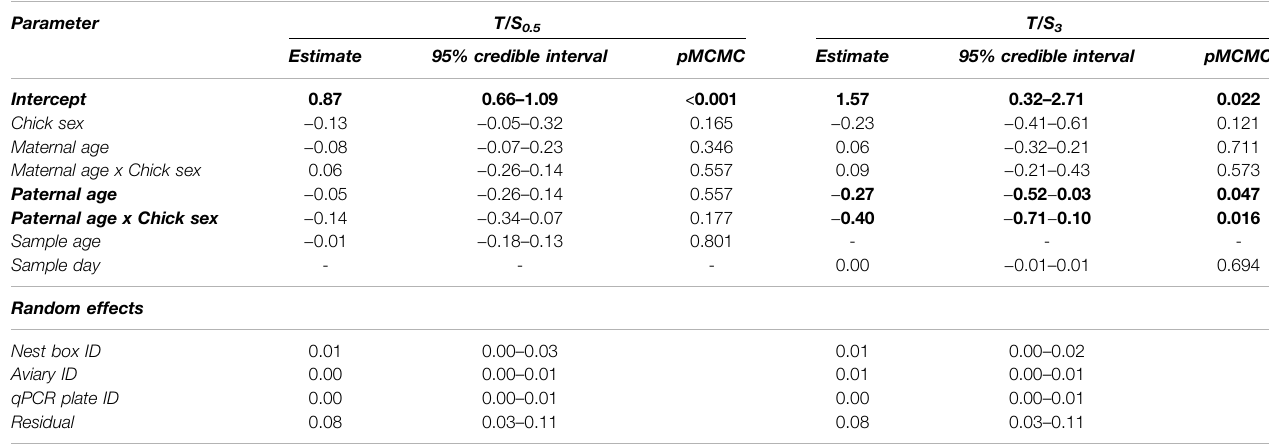
TABLE 2 | Results from two Bayesian MCMC linear mixed-effects models with telomere length of house sparrow chicks at age 0.5 months ( T/S 0.5 ) and 3 months ( T/S 3 ) as response variables, respectively.